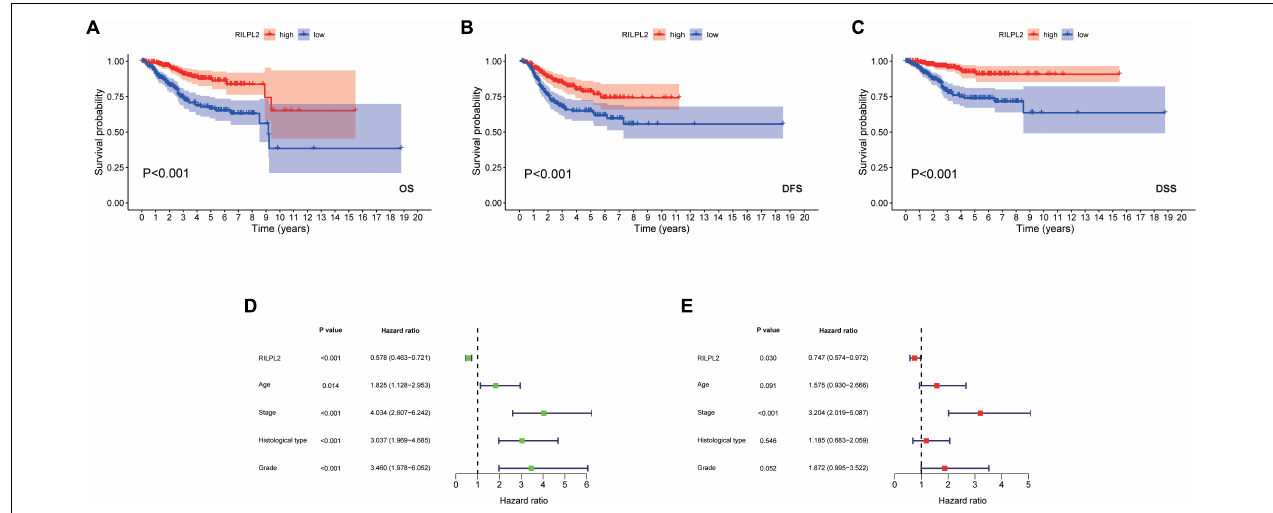
FIGURE 3 | Prognostic value of RILPL2 in EC patients in the TCGA database. (A) OS, overall survival. (B) DFS, disease free survival. (C) DSS, disease specific survival. (D) univariate analysis of RILPL2. (E) multivariate analysis of RILPL2.